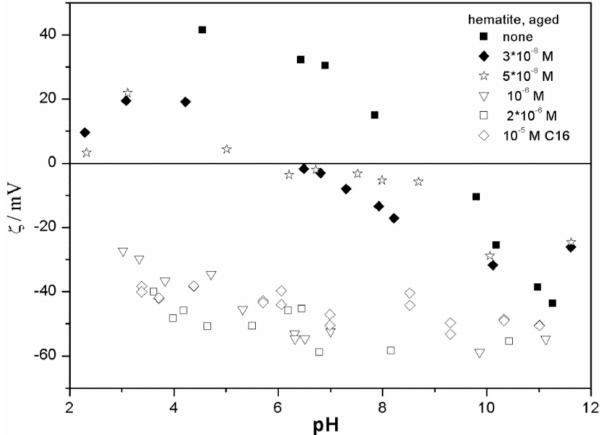
Figure 3. The ζ potential of titania in aged dispersions in the presence of sodium